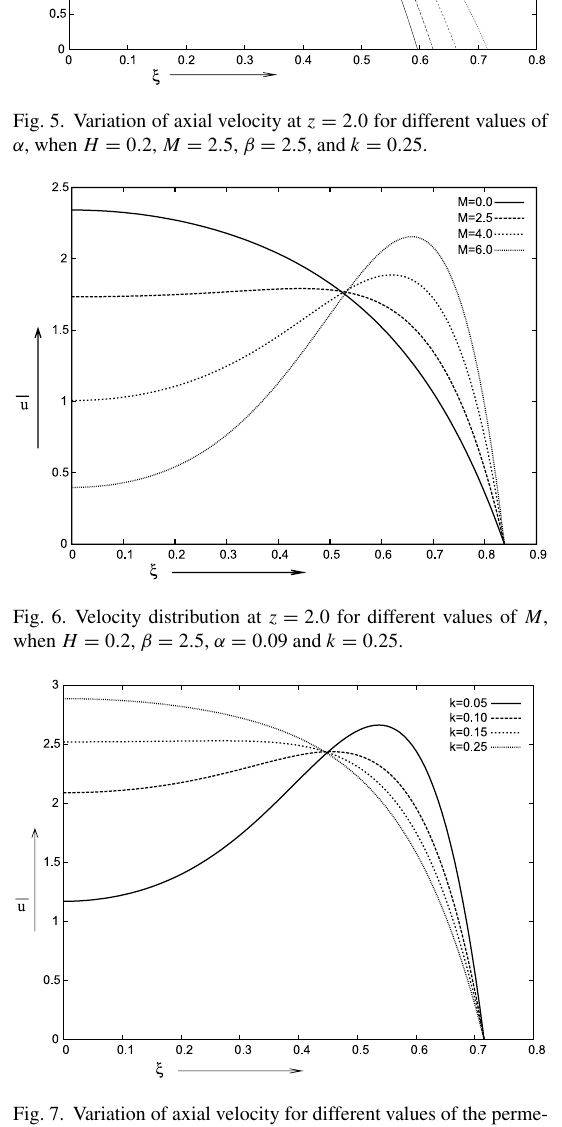
Fig. 7. Variation of axial velocity for different values of the perme- ability parameter k at z = 2 . 0, when H = 0 . 2, M = 2 . 5, β = 2 . 5 and α = 0 .